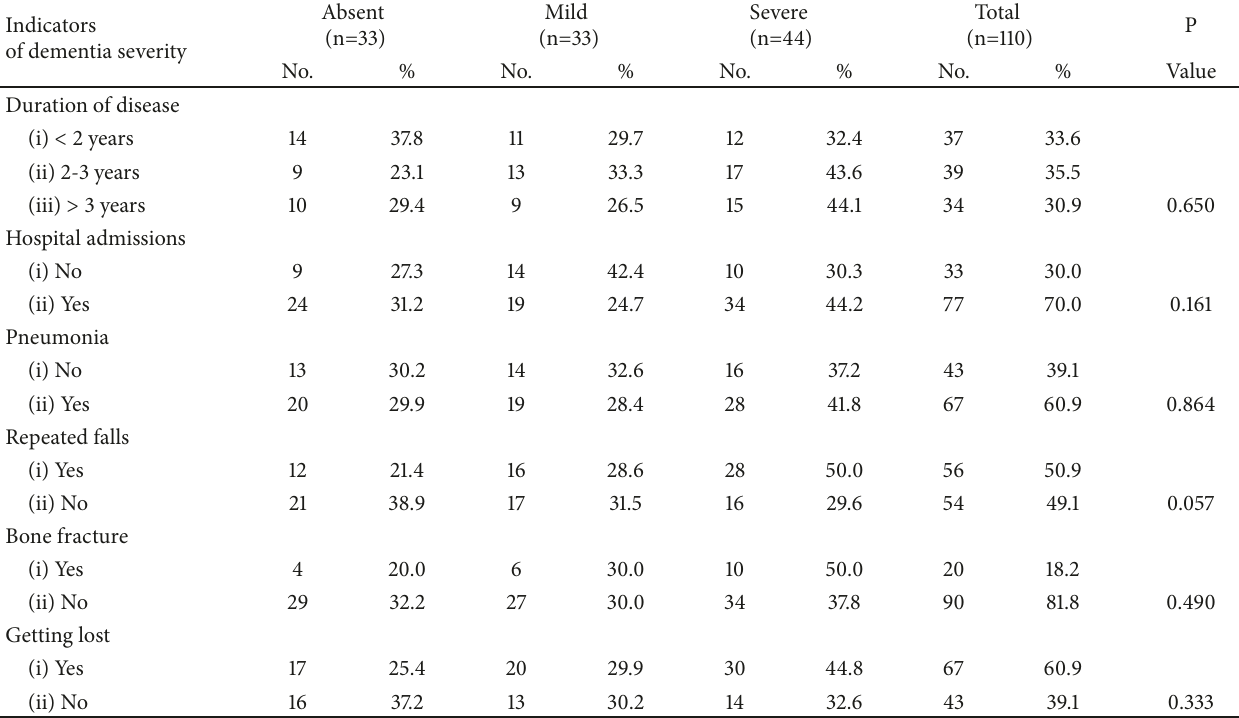
Table 6: Relation between severity of caregivers’ depression and severity of dementia.